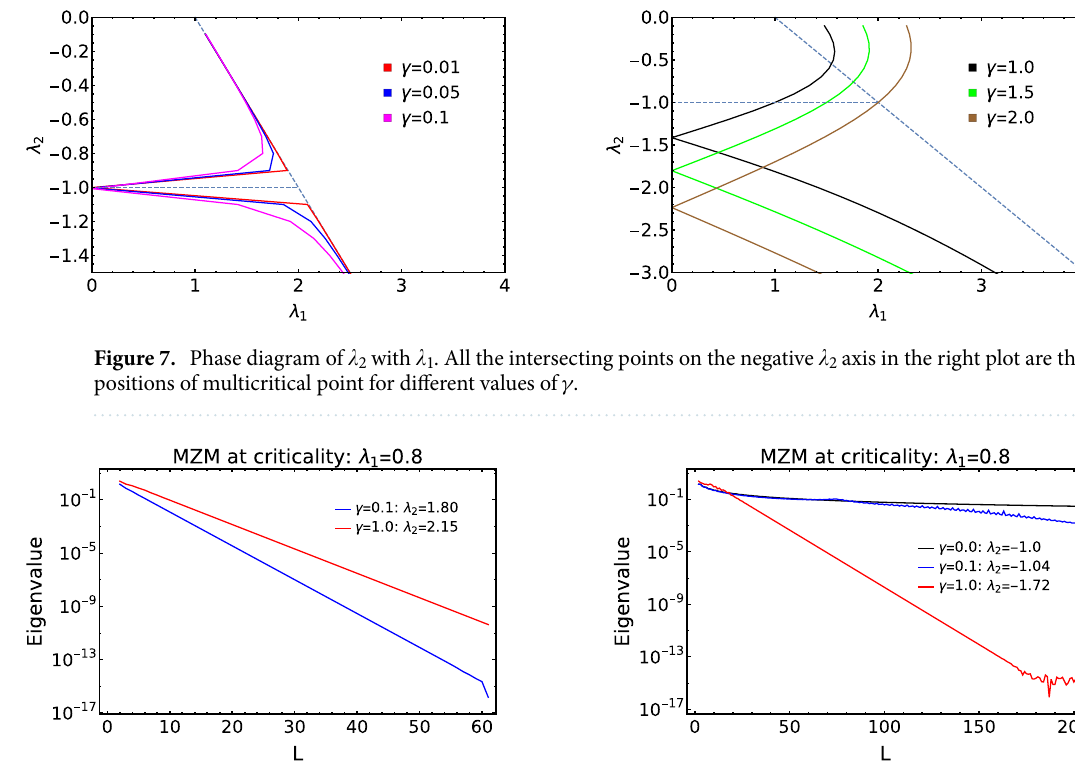
Figure 8. Behavior of zero mode eigenvalues at criticality “qu” and “rs” (refer to the Fig. 1) with system size for different values of γ